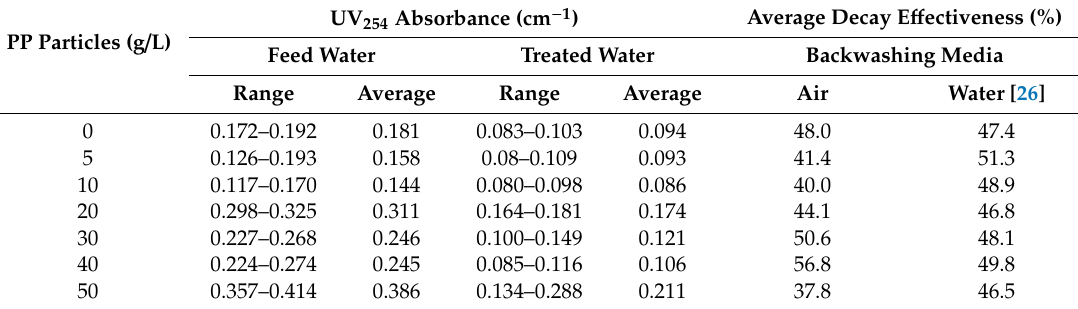
Table 11. Decay e ff ectiveness of DOM (UV 254 absorbance) for influence of the PP particles concentration in the integrated system, of multichannel ceramic MF and PP particles, using air backwashing; paralleled with the consequences of water